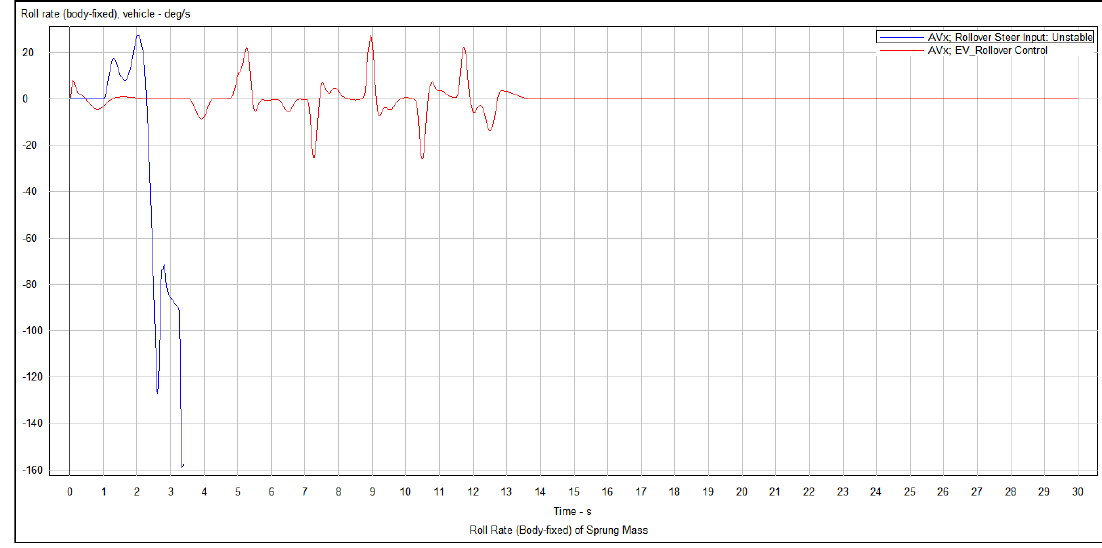
Figure 12. Roll angle comparison curve for double lane-change test.